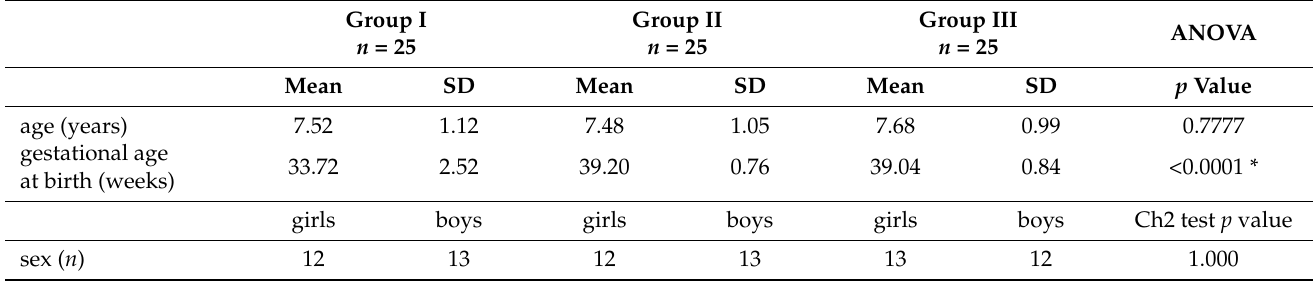
Table 1. Statistical data concerning the subject